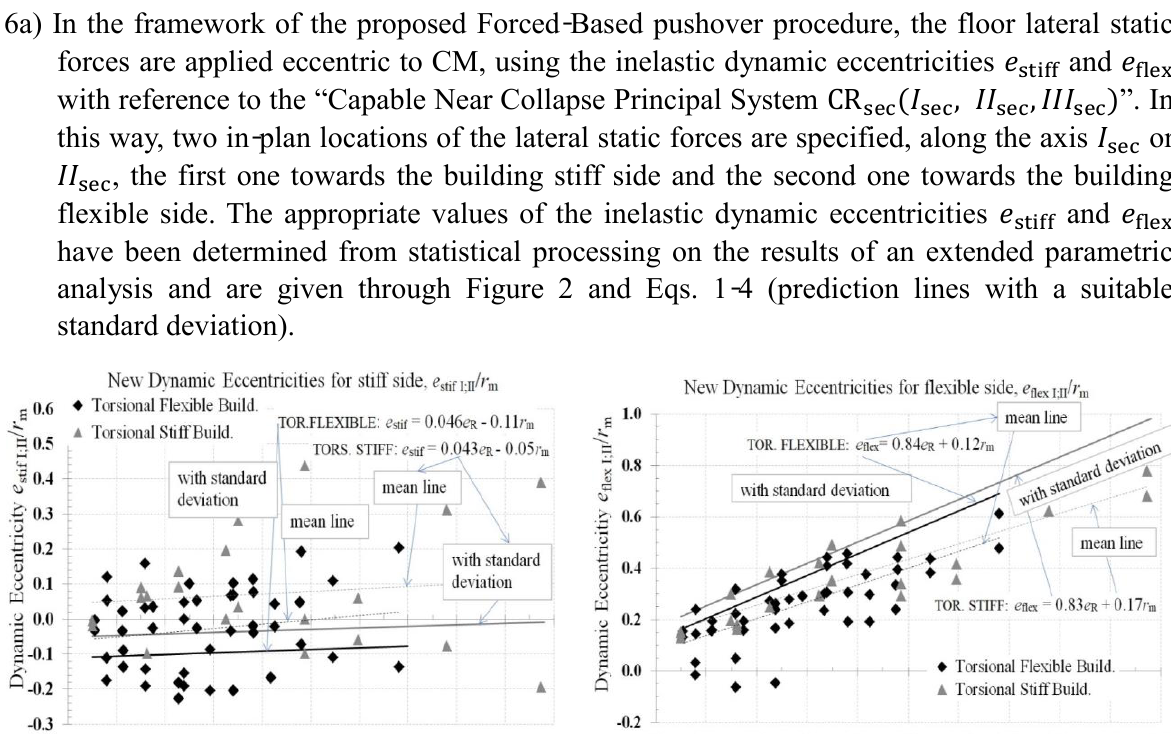
⁄ for the 𝑟 flex I;II m